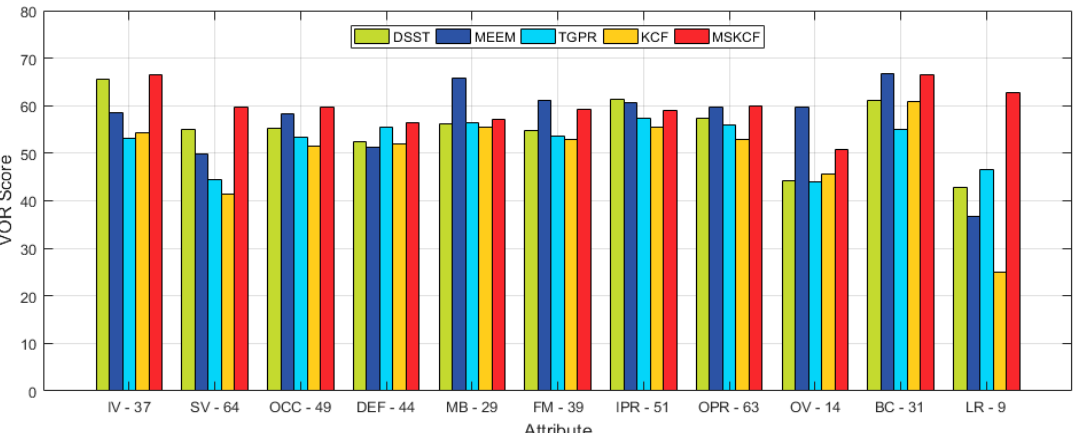
Figure 9. Average VOR ranking scores of the five most successful state-of-the-art trackers [15,16,31,32]. The OTB [38] 100 sequences are annotated with attributes such as illumination variation (IV), out-of-plane rotation (OPR), scale variation (SV), occlusion (OCC), deformation (DEF), motion blur (MB), fast motion (FM), in-plane rotation (IPR), out-of-view (OV), background clutter (BC), and low resolution (LR). The number next to each attribute indicates the number of sequences with this attribute.